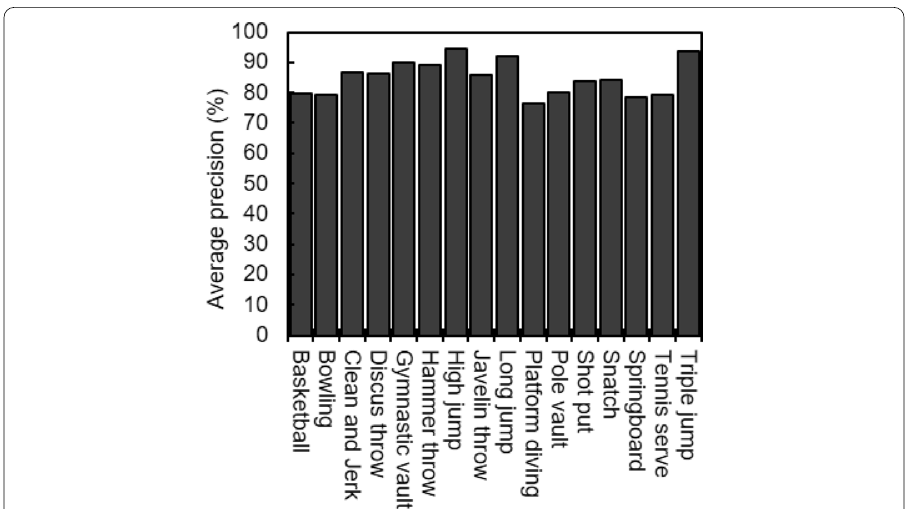
Fig. 13 The detailed accuracy by class for the Olympic Sports dataset